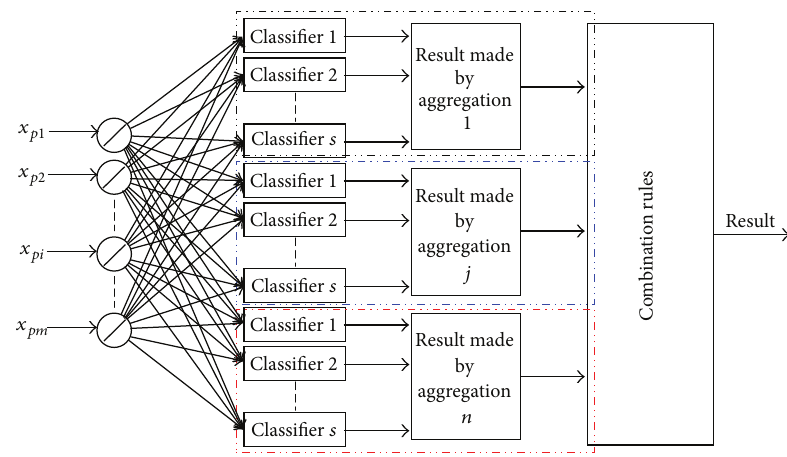
Figure 4: Multiple classifier aggregations to multiple faults classes.